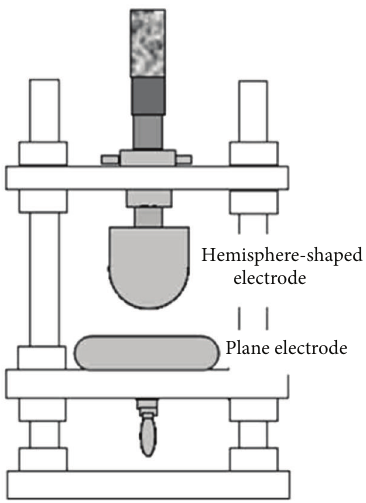
Figure 12: Sphere plane electrode system configuration